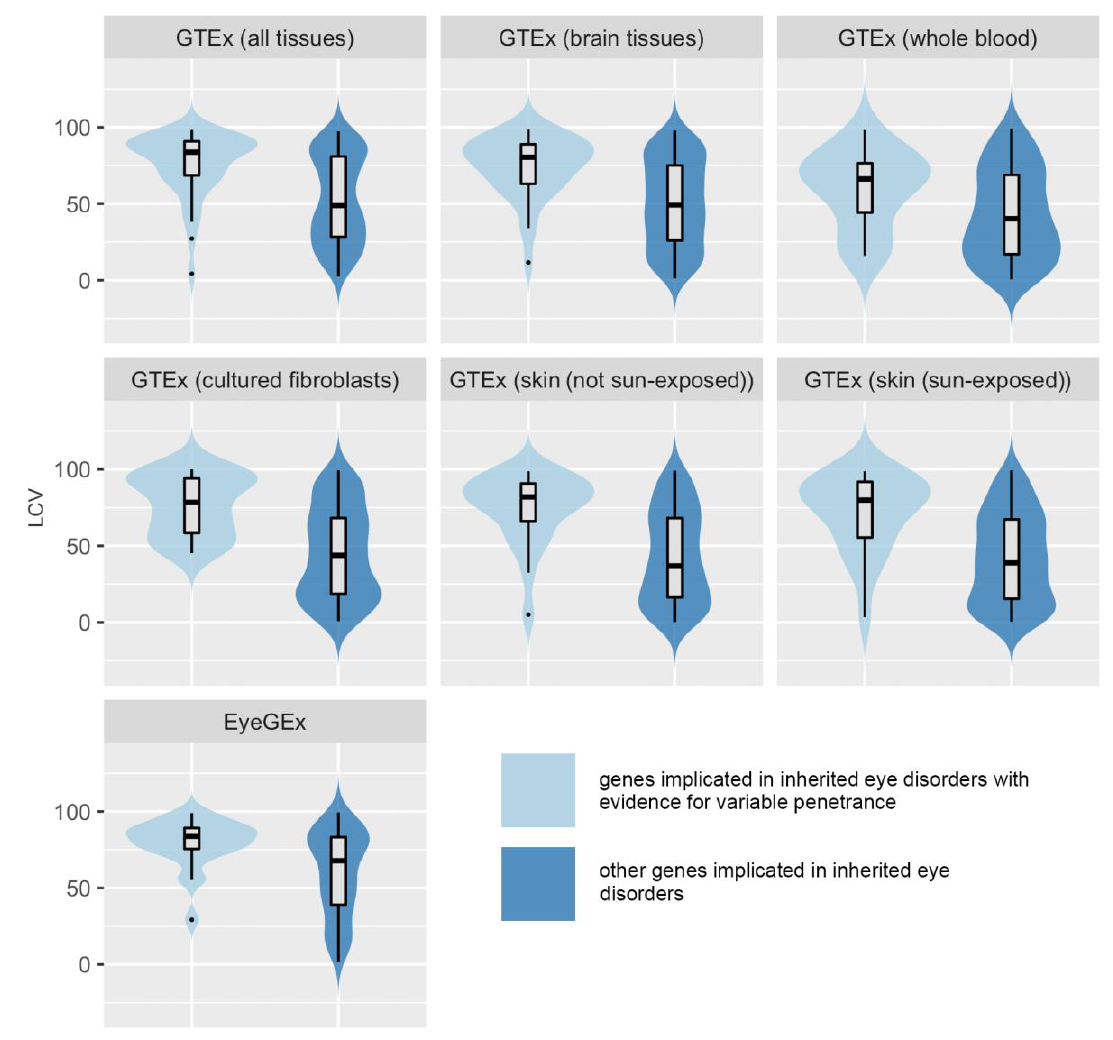
Figure 2. Violin plot showing comparisons of gene expression levels between inherited eye disease-implicated genes with evidence for variable penetrance and inherited eye disease-implicated genes for which no evidence of variable penetrance was found. The relevant p -values are presented in Table 1. LCV, local coefficient of variation; GTEx, Genotype-Tissue Expression project version 8 dataset [9]; and EyeGEx, Eye Genotype Expression (EyeGEx) dataset [18].